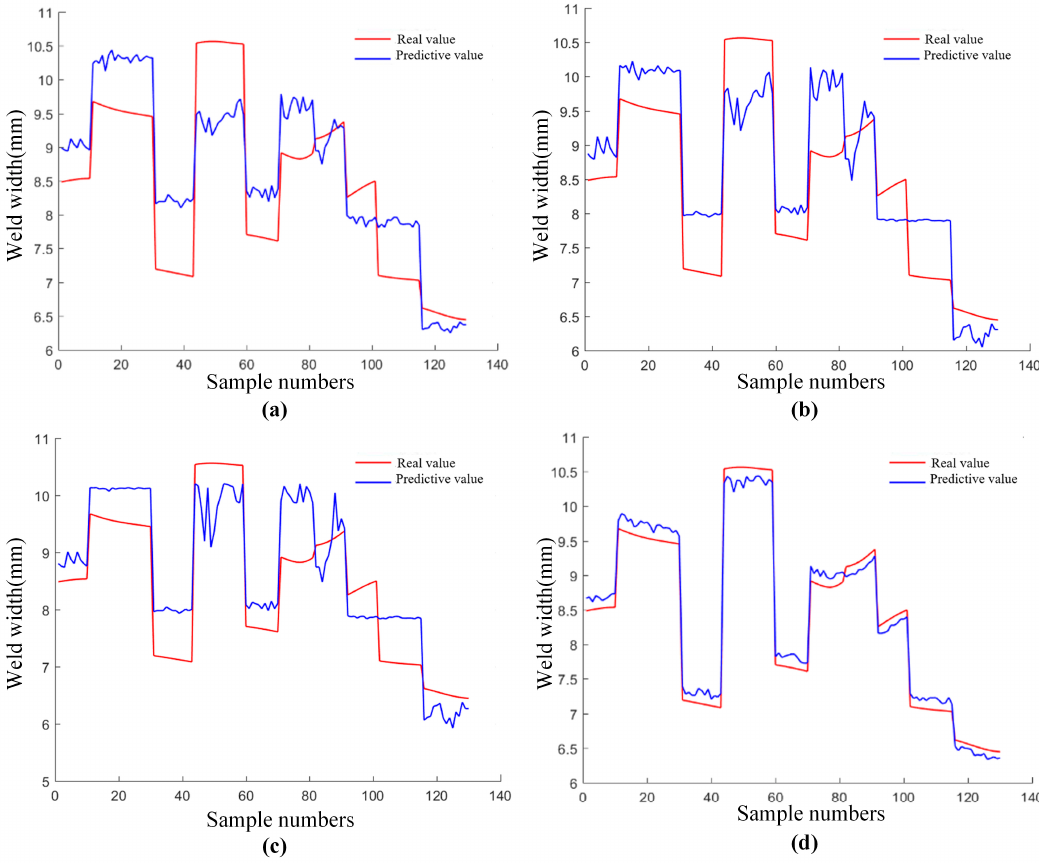
Figure 16. Comparison between molten pool pixel width and weld width of several prediction methods: ( a ) ordinary primary fitting; ( b ) Gaussian primary fitting; ( c ) Gaussian secondary fitting; ( d ) prediction method based on BP neural network.